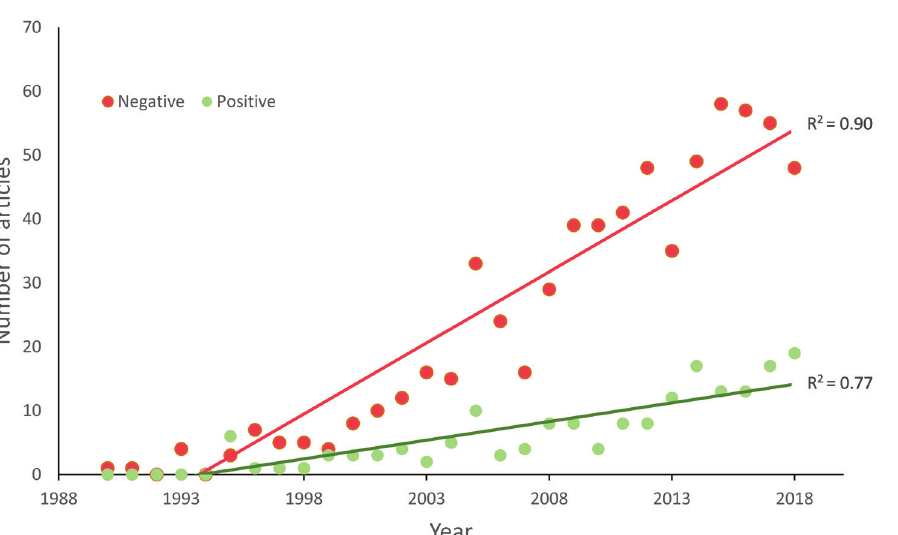
Figure 2. Plot reporting the number of articles and fitted linear regression obtained using the following search strings in Google Scholar at the end of October 2019: In red : “negative * of alien species “ OR “negative * of non-native species “ OR “negative * of exotic species” OR “costs of alien species “ OR “costs of non-native species “ OR “costs of exotic species”; In green : “positive * of alien species “ OR “positive * of non-native species “ OR “positive * of exotic species” OR “benefits of alien species “ OR “benefits of non-native species “ OR “benefits of exotic